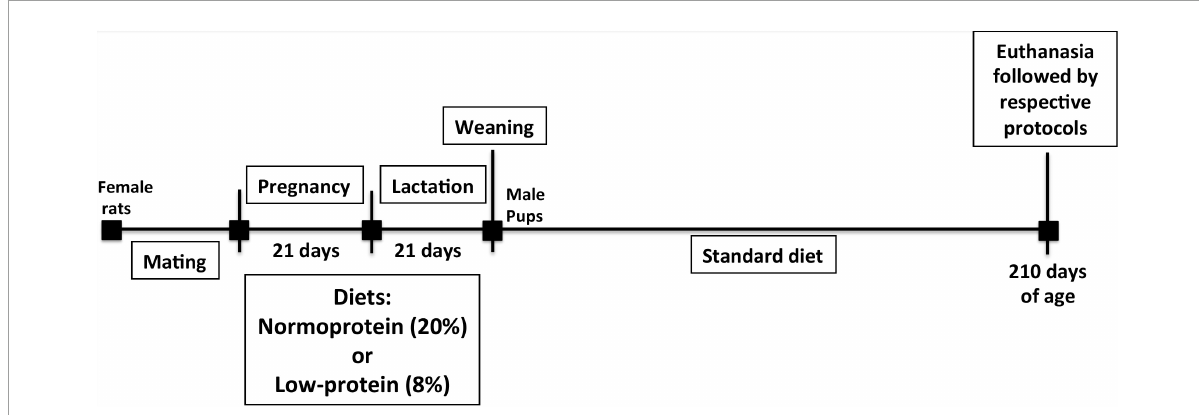
FIGURE1 Experiment design. Once gestation was confirmed, a normoproteic or low-protein diet was administered to rats during pregnancy and lactation. After weaning, the offspring of both groups were fed a standard laboratory diet until the 210th day postpartum. The pups were then euthanized, and an analysis was